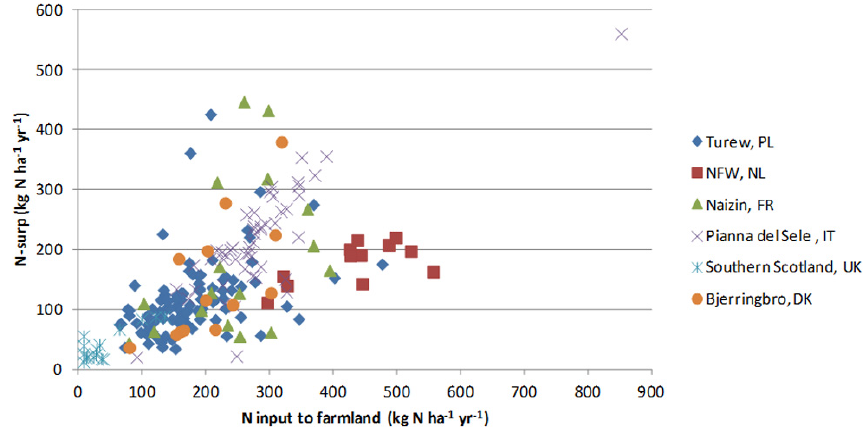
Fig. 6. Calculated farm N surplus (N-surp) as a linear function of N input to farmland, estimated as the average input per field area (total N input to each farm from fertilisers, manures, N-fixation and deposition from the atmosphere). The landless Scottish poultry farms are